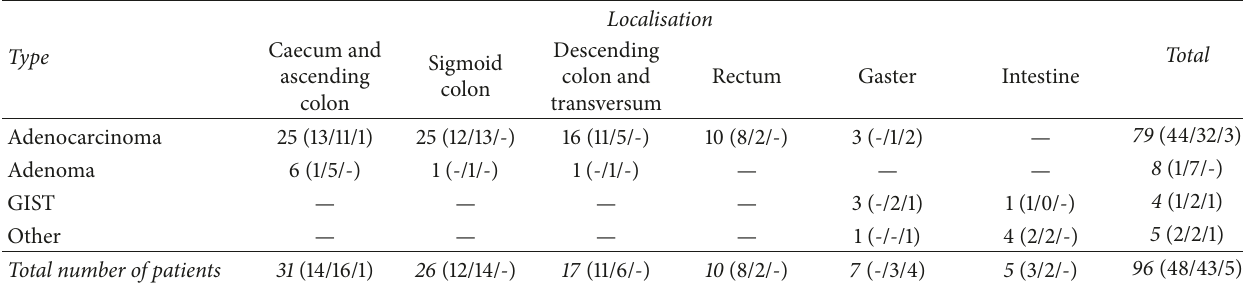
Table 1: Tumour localisation and type for patients involved in the study. GIST stands for gastrointestinal stromal tumour. “Other” tumour types included undifferentiated neoplasm (for gaster) and neuroendocrine carcinoma, hemangioma, fibroid polyp, and undifferentiated neoplasm (for intestine). Brackets contain numbers of open surgeries, laparoscopic surgeries, and robot-assisted surgeries, respectively.